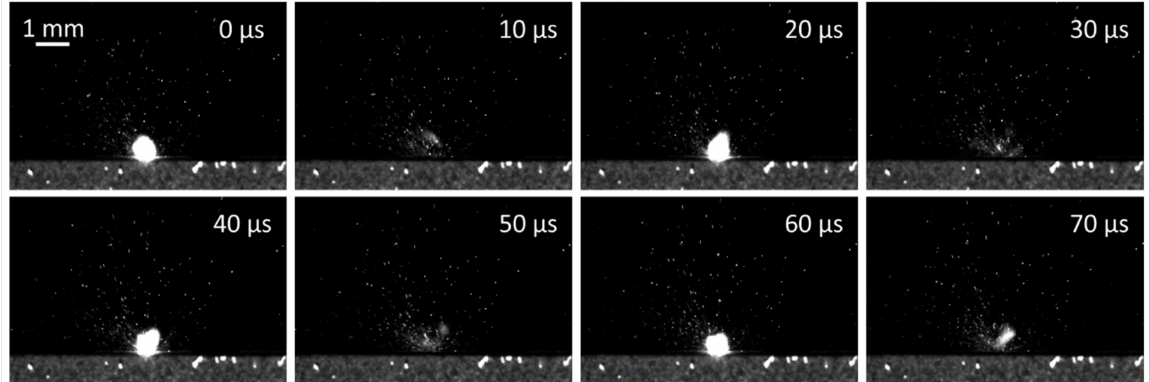
Figure 5. Laser ablation of stainless steel AISI 316L using pulse duration t p = 240 ns and pulse repetition rate f = 48